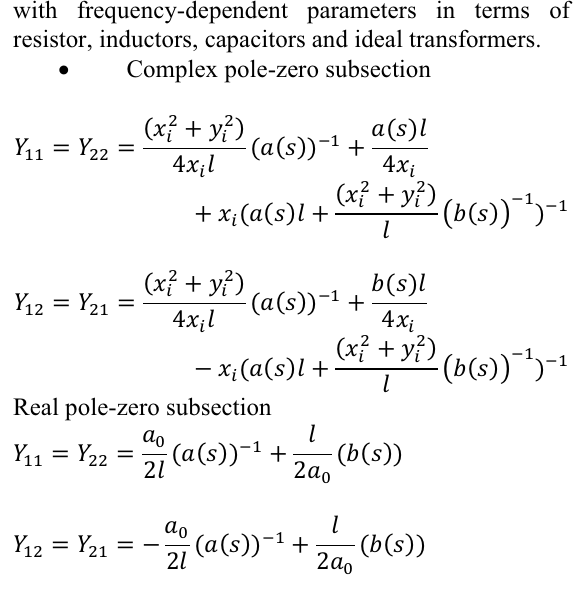
represent the internal voltages and currents created by the Pade macro-model.